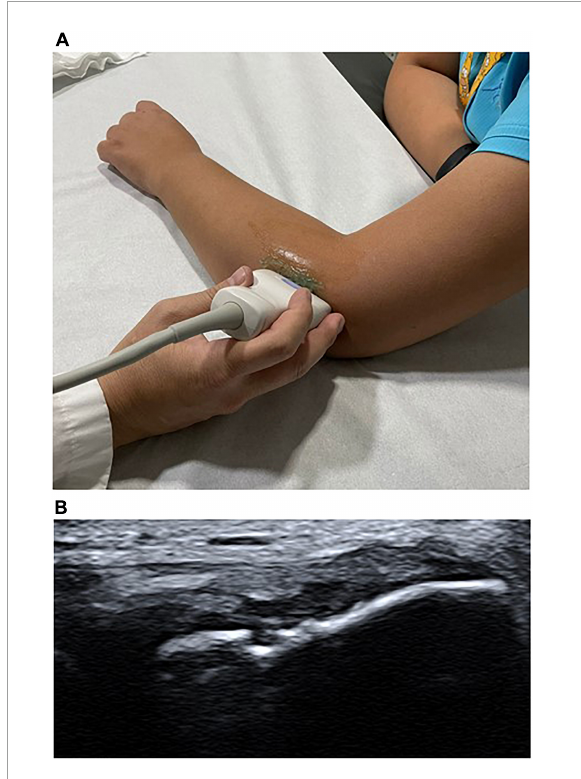
FIGURE2 Patient evaluation position and an ultrasound (US) finding, respectively. (A) Probe positioning in the elbow in the US exploration of the extensor tendon complex. (B) US imaging shows intrasubstance tear in extensor tendon